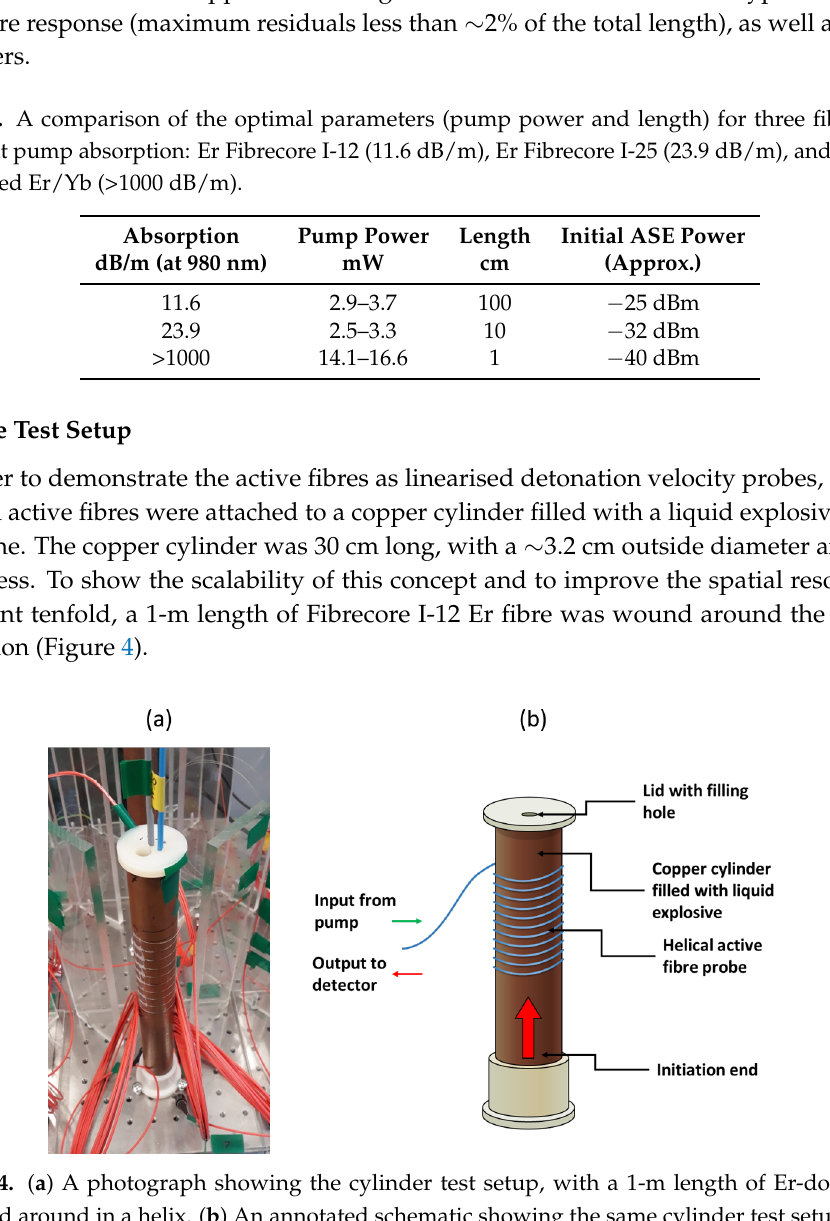
wrapped around in a helix. ( b ) An annotated schematic showing the same cylinder test